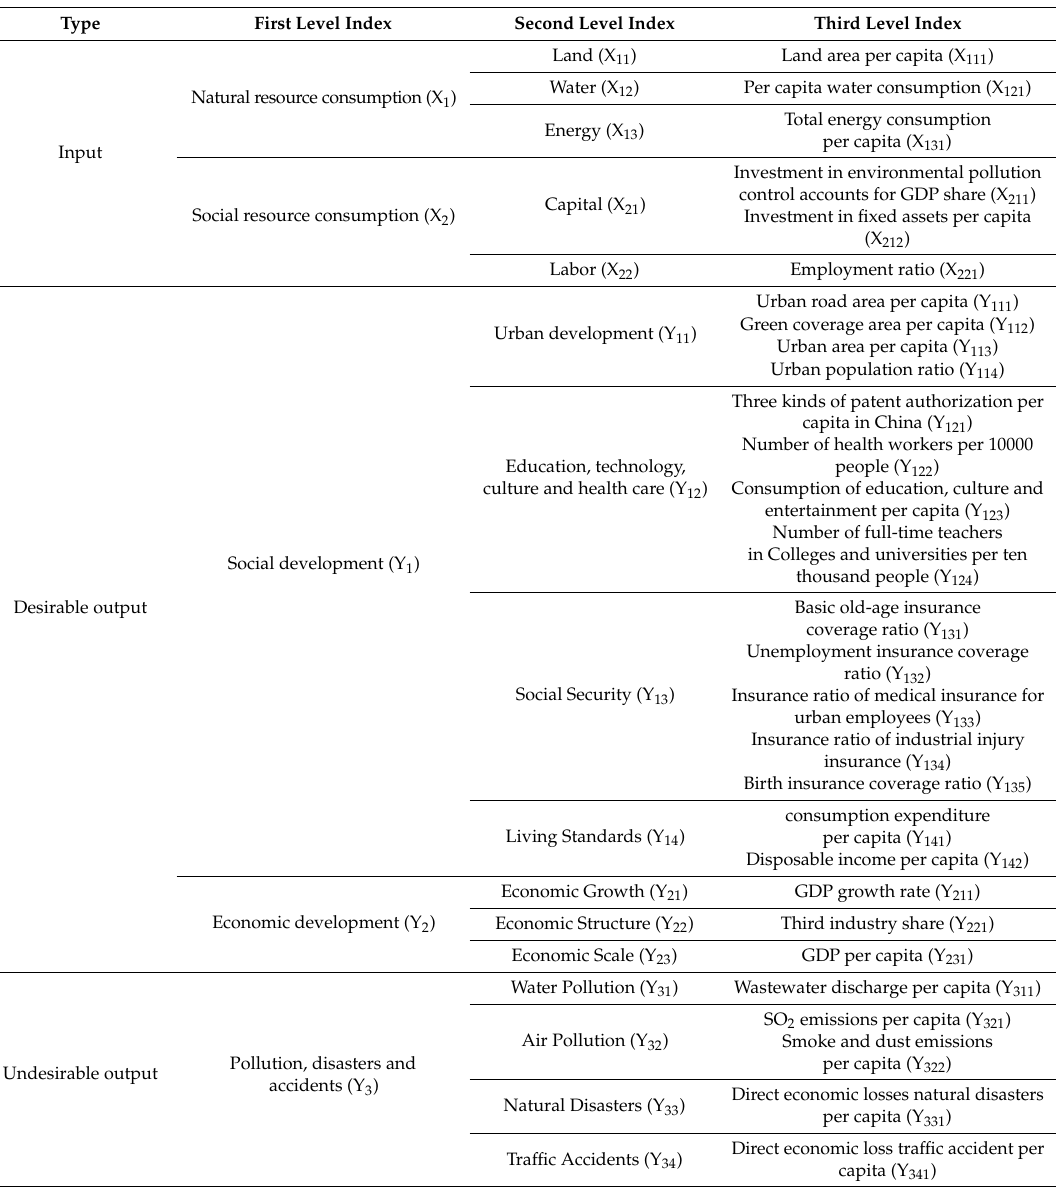
Table 1. Evaluation index system for regional sustainable